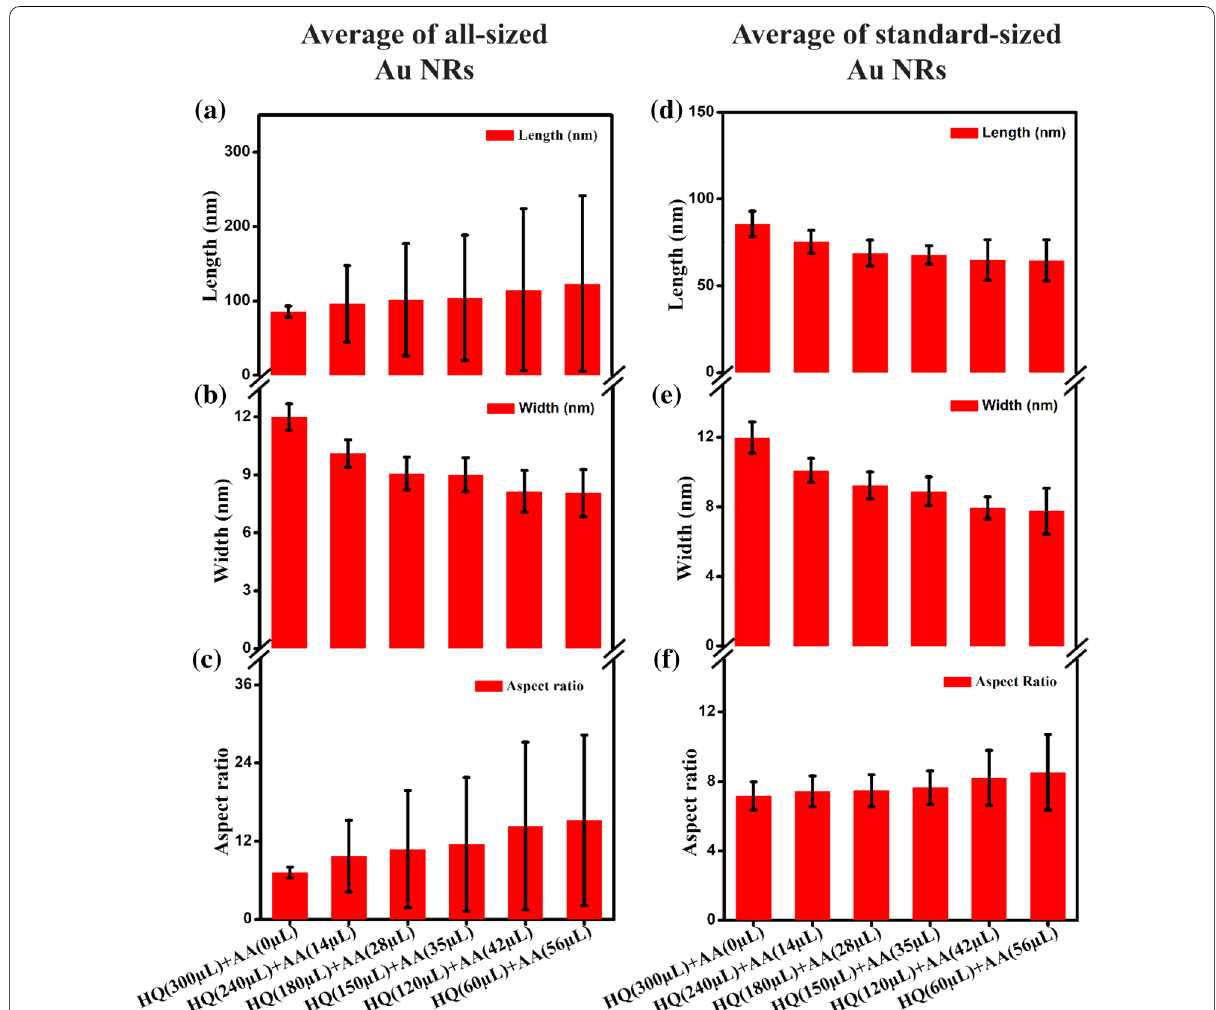
Fig. 5 Average of a length, b diameter, and c aspect ratio of all-sized Au NRs. Average of d length, e diameter, and f aspect ratio of standard-sized Au